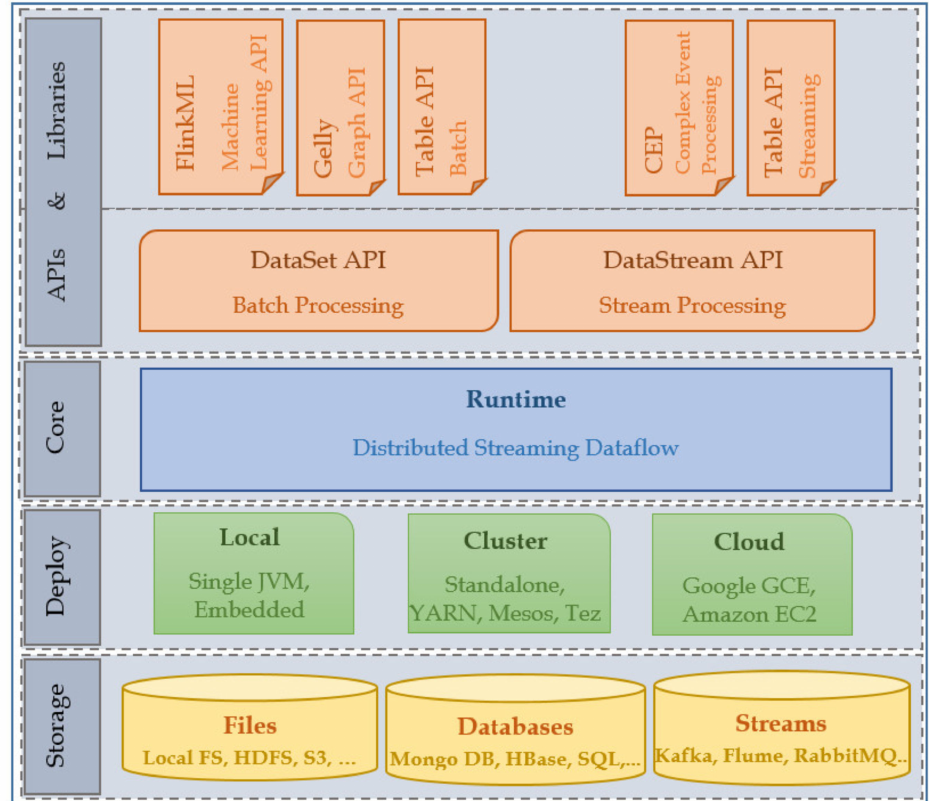
Figure 9. Apache Flink